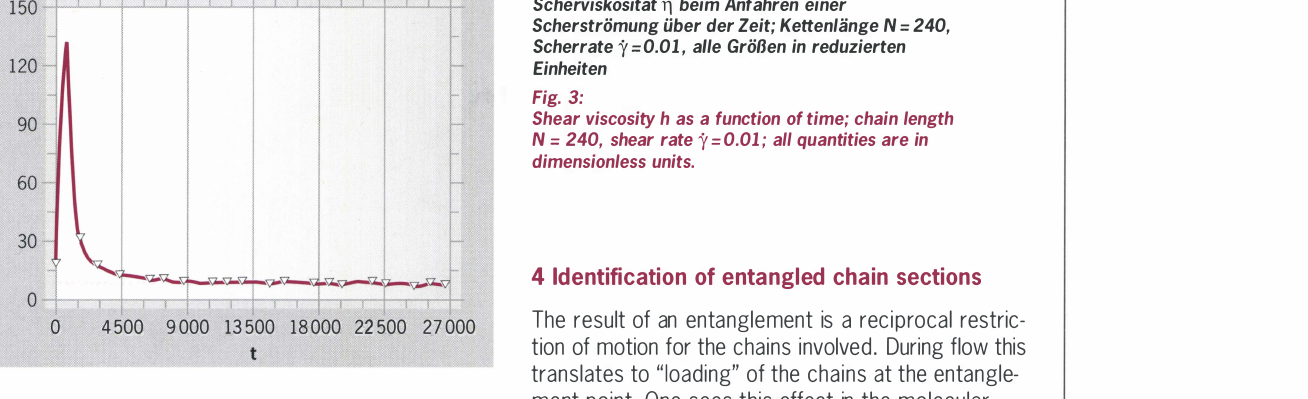
Abb. 4: Quadrierte Bindungskriifte;